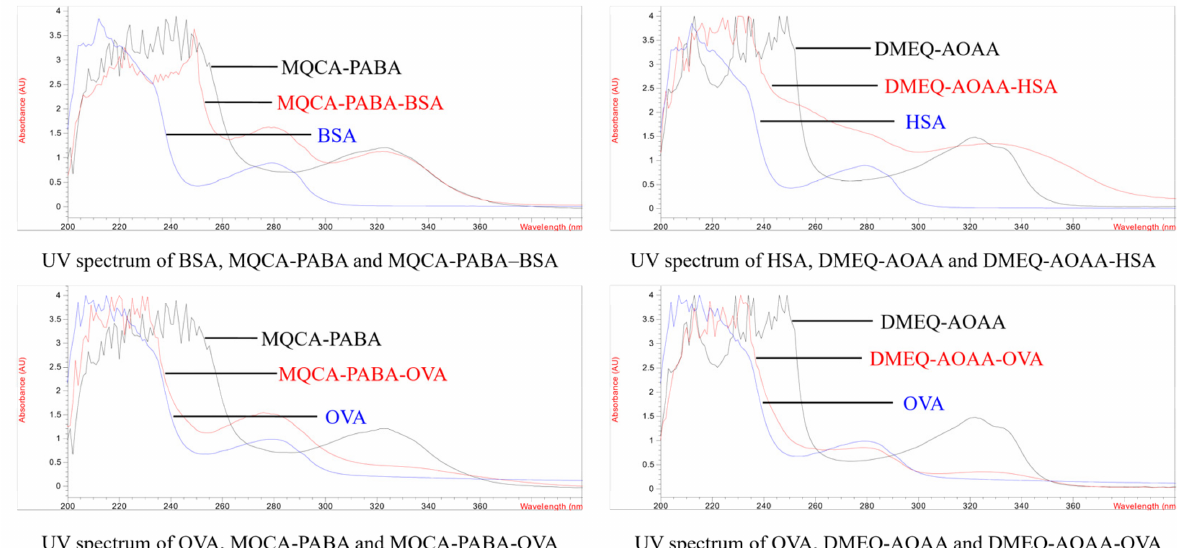
Figure 3. UV absorption peak spectra of 4 different antigens at 200–400